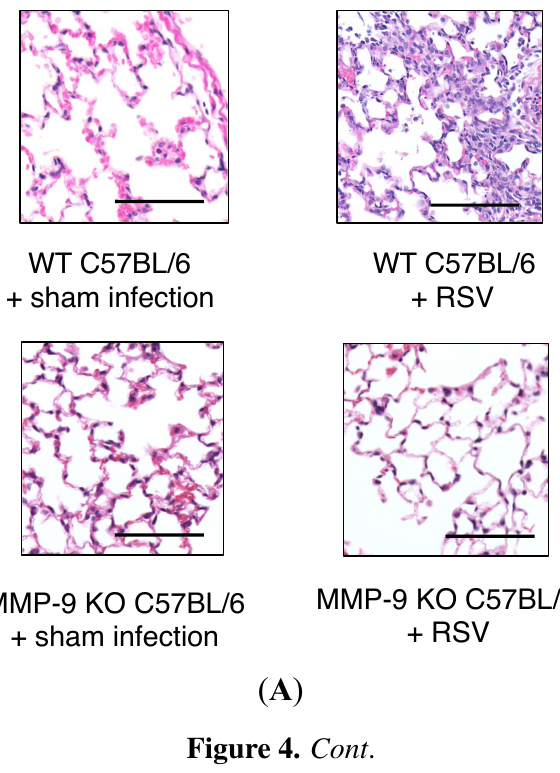
Figure 4. Cont Figure 4. Cont .